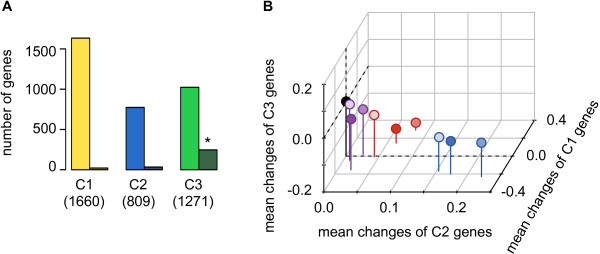
Genes having similar transcriptional change dynamics. A. Gene clusters. The three gene clusters determined by K-means clustering are shown in yellow (C1), blue (C2), and green (C3). The number of genes in each cluster is indicated. The essential genes comprising the three clusters are shown in dark green. An asterisk indicates the statistical significance (p < 0.01) of the biased number of essential genes within cluster C3, as evaluated using binomial tests. B. The three-dimensional space formed by the three clusters. Clusters C1, C2, and C3 are represented by the axes z, x, and y, respectively. The lines representing zero on the three axes are indicated using dashed lines. Gene expression under regular conditions is marked in black and located at the zero points of all three axes. Gene expression under the three studied environmental types having varied growth rates are indicated separately. The use of color hue and saturation are as described in Figure 1: osmotic pressure (blue), temperature (red), and starvation (violet).